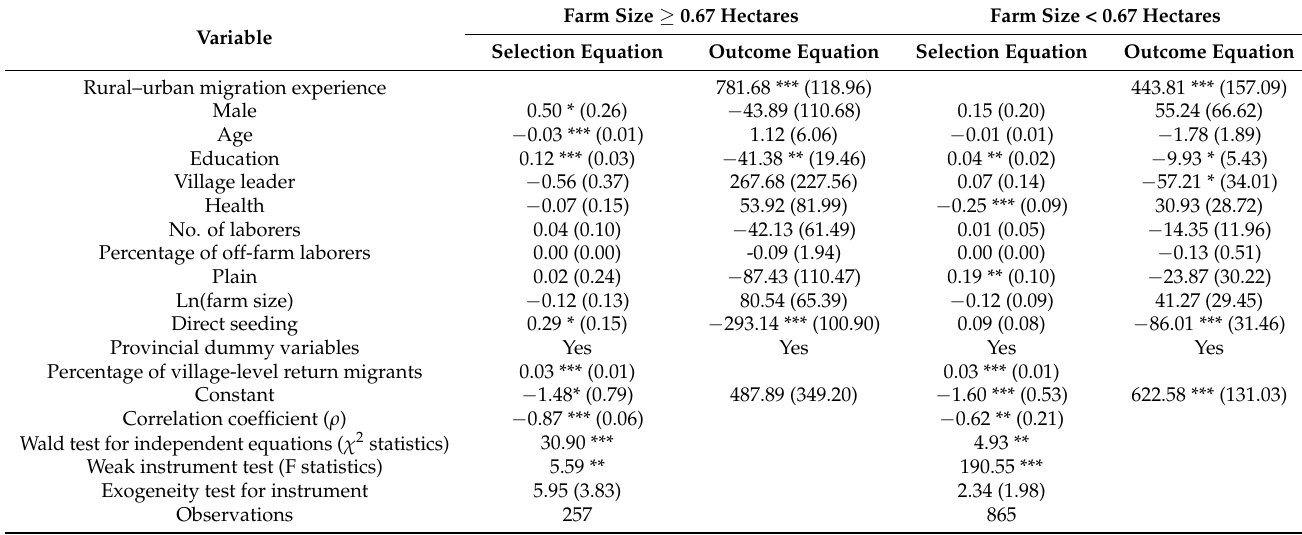
Table 5. Heterogeneity analysis of the impact of rural–urban migration experience on agricultural mechanization by farm